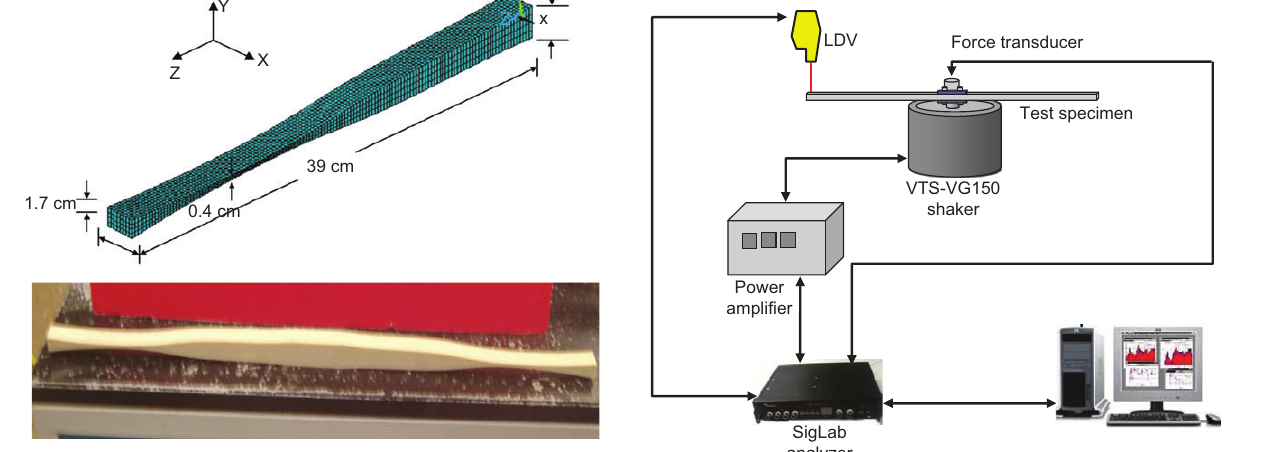
Figure 7 Experimental setup used for vibration fatigue